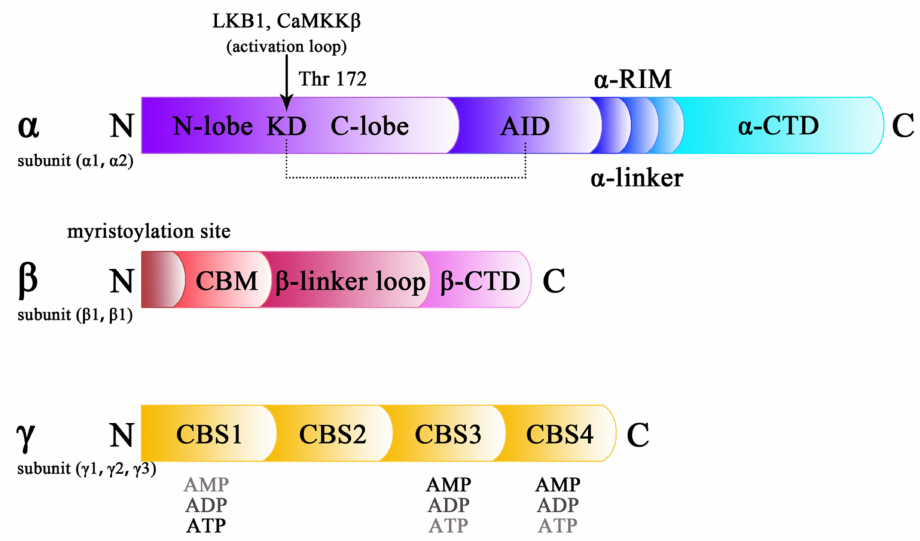
Figure 1. Domain structure and three subunits of the AMPK protein. Upstream kinases, including LKB1 and CaMKK β , can phosphorylate the activation loop in the kinase domain (KD). Binding of AMP to the γ subunit leads to conformational changes in AMPK, interacts with α -regulatory subunit-interacting motif ( α -RIM) and exposes KD to activators, which boost the allosteric activation of